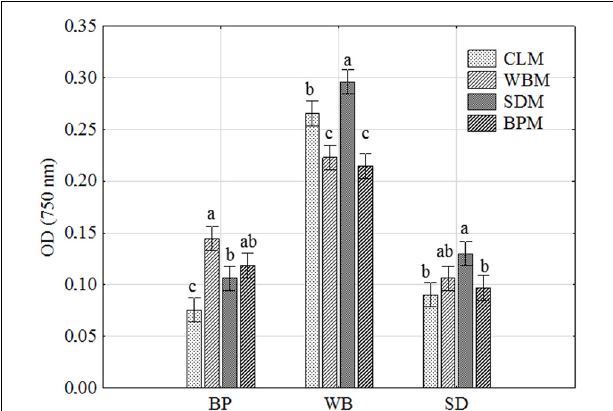
FIGURE 1 | Petriella setifera decomposition ability of waste-based substrate located in the MT2 plate R (cid:13) as influenced by preculturing. SD, oak sawdust; BP, beet pulp; WB, wheat bran; SDM, oak sawdust medium; BPM, beet pulp medium; WBM, wheat bran medium; CLM, control medium; OD, optical density. The vertical bars indicate the confidence intervals at 0.95. Different letters above the bars indicate errors in the significance of differences ( α = 0.05) between the mean values of OD [Tukey’s test ( p < 0.05)], n = 4.